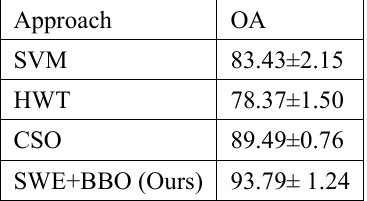
Table 8. Comparison with other